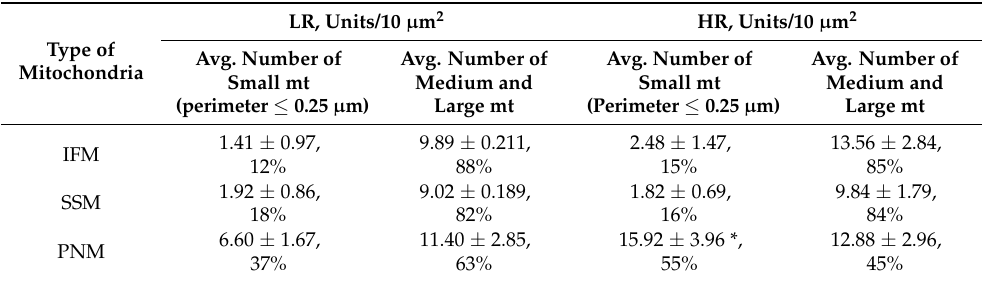
Table 1. Morphometric characteristics of three subpopulations of mitochondria in the myocardium of LR and HR rats under normoxic